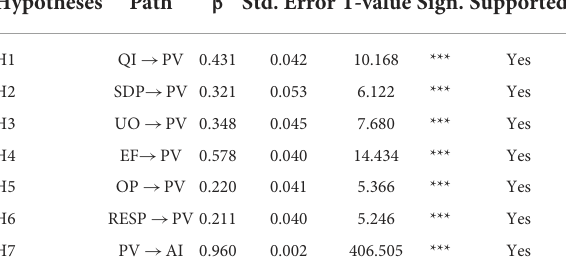
TABLE 5 Results of